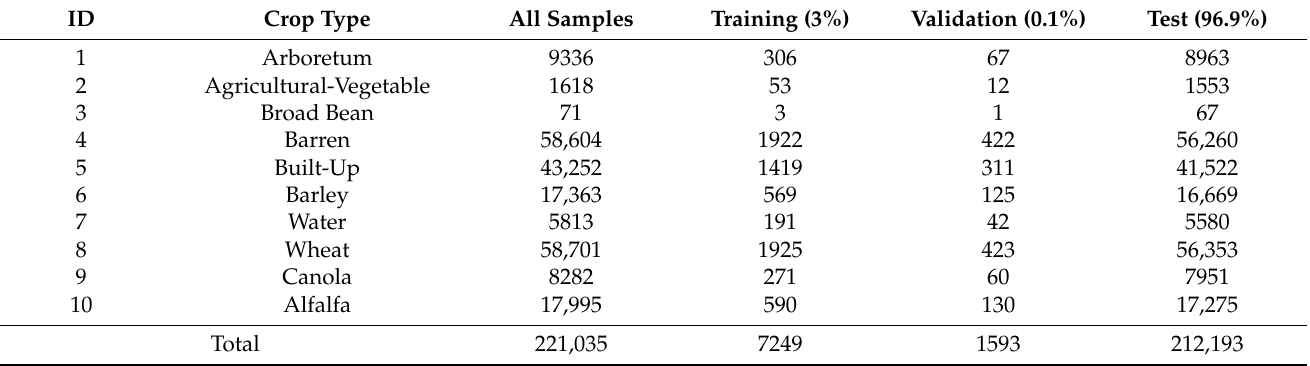
this study, random sampling was employed to divide reference samples into training (3%), validation (0.1%), and test (96.9%) samples. Table 2. The number of reference samples that were divided into training, validation, and test